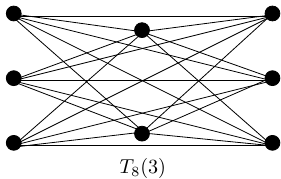
Figure 2. A Turan